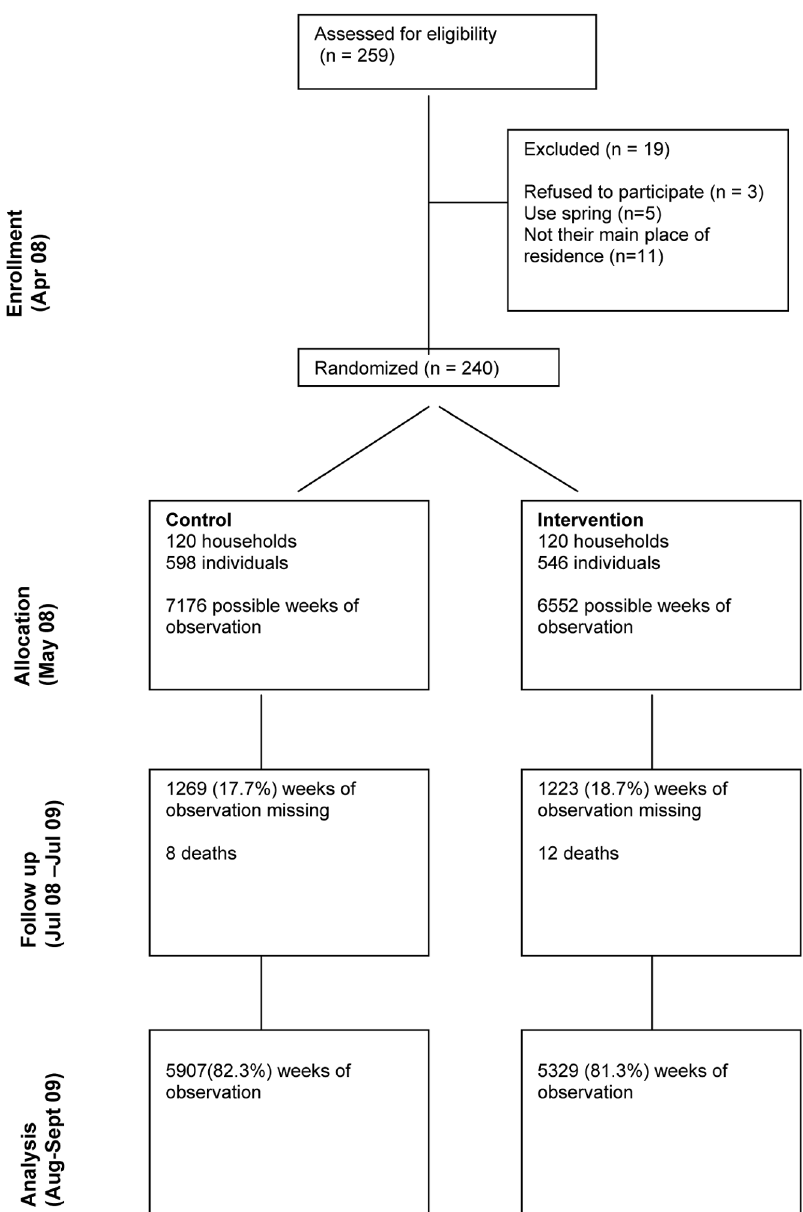
Figure 1. CONSORT diagram showing the flow of participants through the trial.